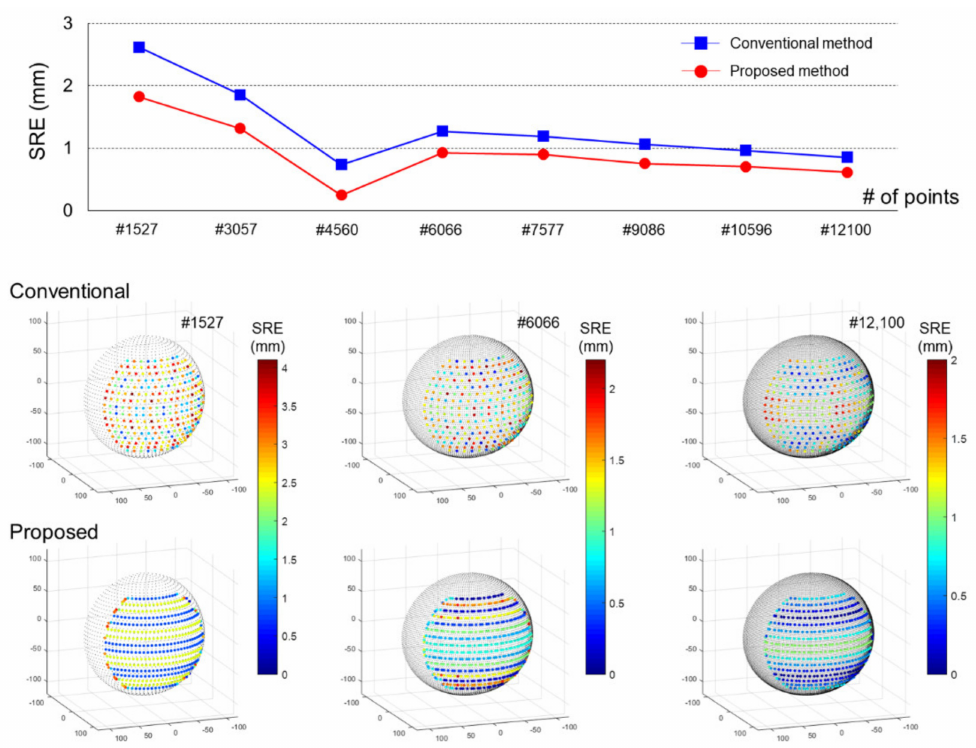
Figure 4. Comparison of surface registration error (SRE) between the conventional and proposed registration strategies using the hemisphere model.